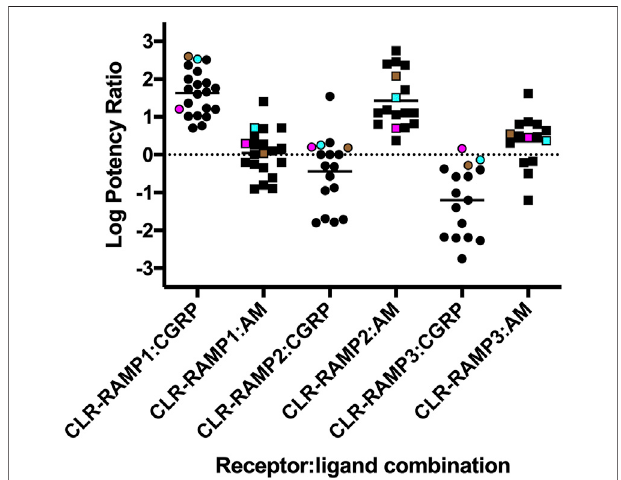
FIGURE6| AgonistpotencyrationsforCGRP,AMandAM2atthethree different CLR-RAMP complexes. The log Potency ratios (as determined from cAMP accumulation assays) are de fi ned as log(EC50 AM2/EC50 agonist). Data compiled from Weston et al., (2016), Garelja et al., (2020), Clark etal.,(2021)andHarrisetal.,(2021).HEK293TcellsexpressingCLR-Nlucare shown in cyan , HEK293 expressing CLR-Nluc are shown as magenta and HEK293T cells expressing HA-CLR are shown in brown